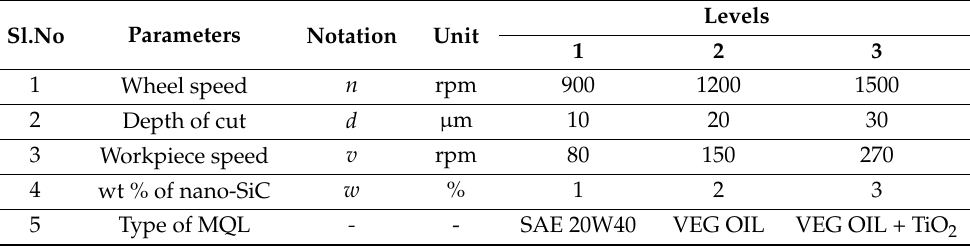
Table 3. Grinding parameters and their